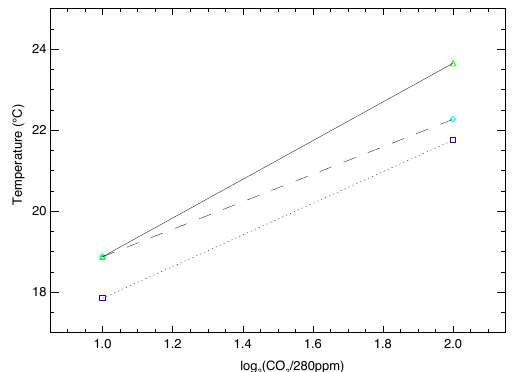
Fig. 8. Climate sensitivity measured by HadCM3L with dynamic vegetation (solid line), fixed homogeneous shrubs (dotted line) and fixed, non-homogeneous vegetation (dashed